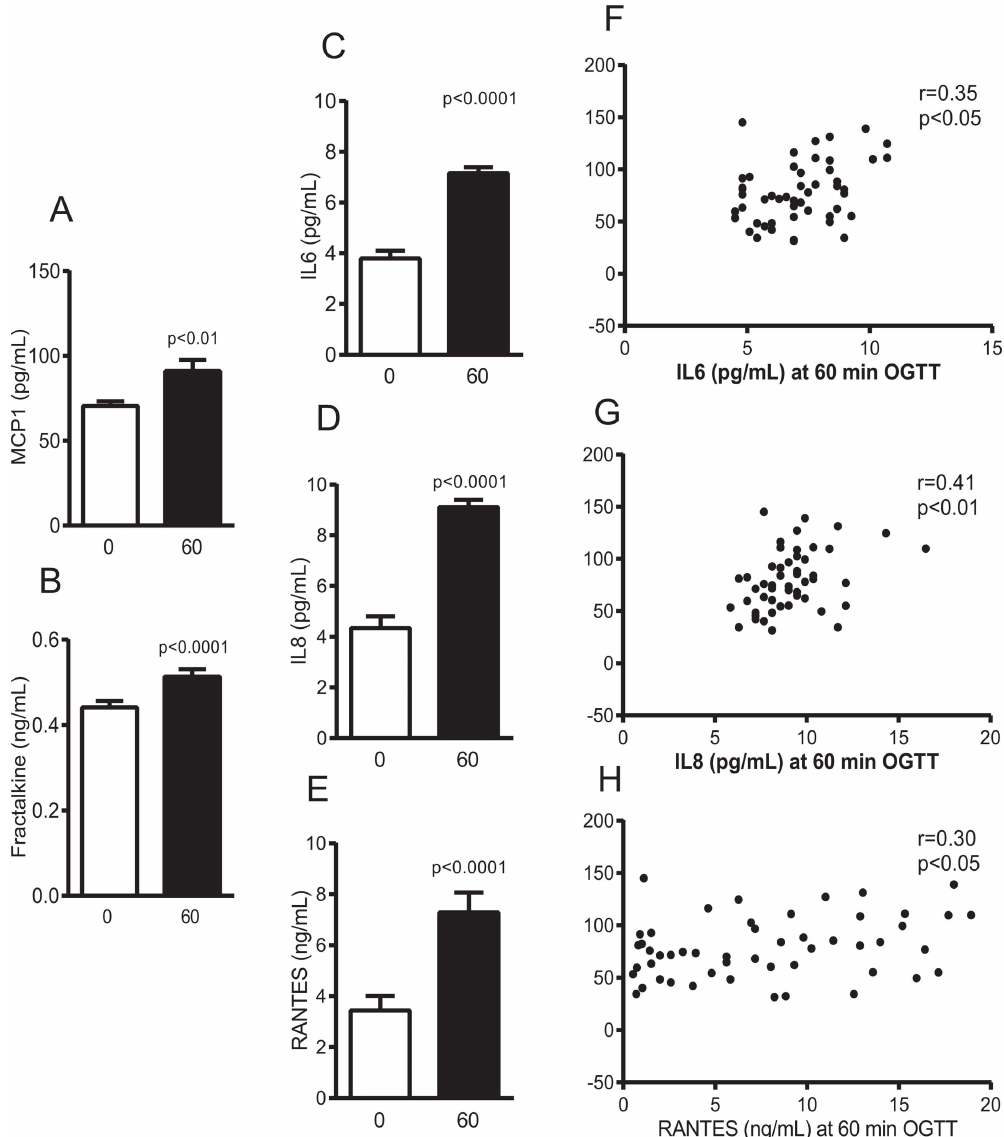
Fig 3. Plasma chemokine concentrations before and at 60 min after a 75-g oral glucose load (A-E) and Spearman correlations of IL6 (F), IL8 (G) and RANTES (H) with insulin secretion rate. Mean ± SE.